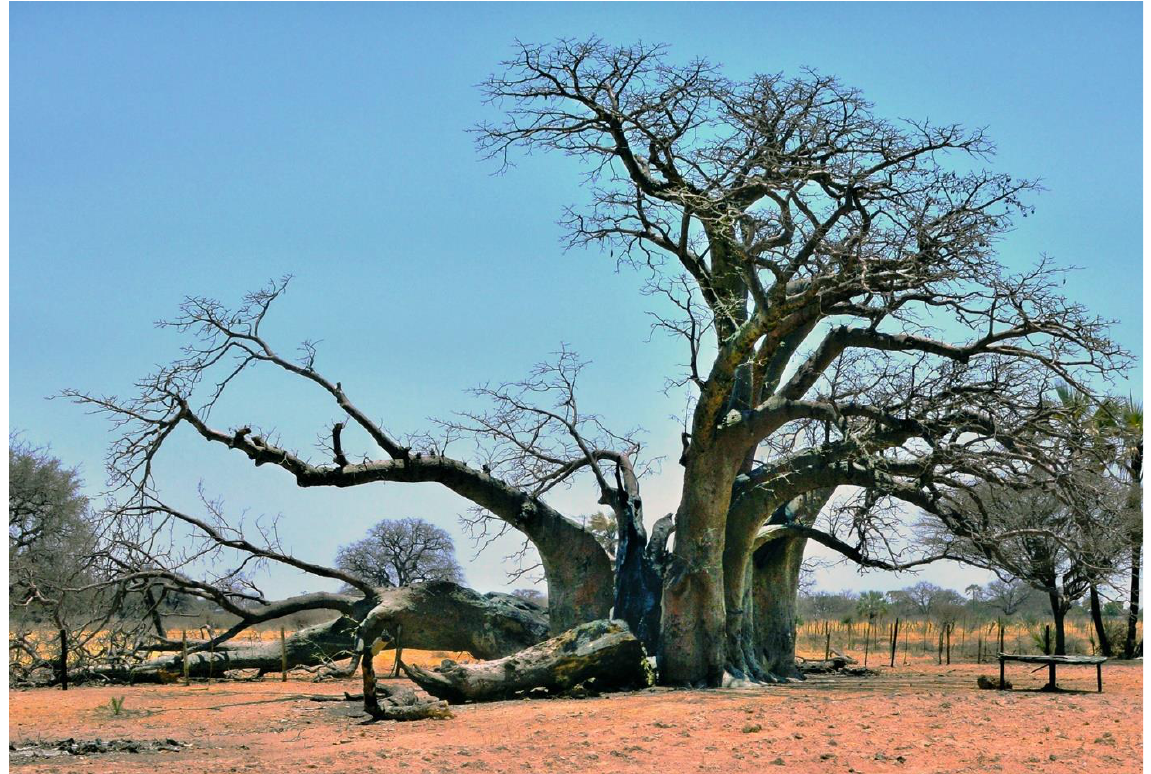
Figure 8. The image shows the Amadhila baobab after the first collapse of April 2021, when several stems toppled toward the west.